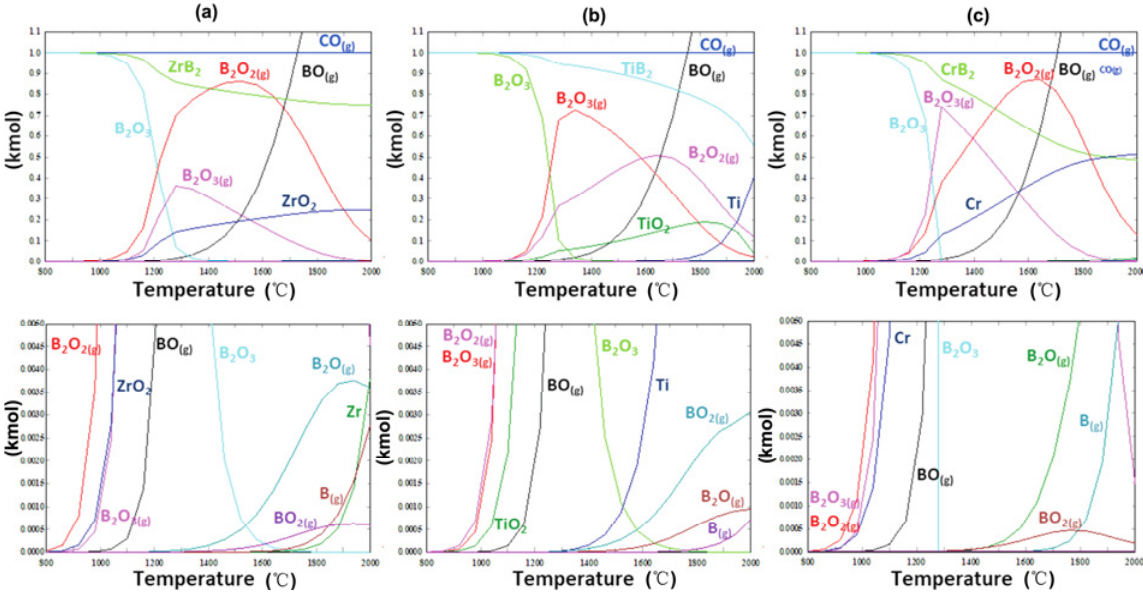
Fig. 12 Thermochemical equilibria of the products deriving from the reaction TMB 2 + 1CO (g) + 1B 2 O 3(g) , with TM = Zr (a), Ti (b), and Cr (c), as a function of the temperature and at constant pressure of 10 − 4 bar. In the bottom, a zoomed portion of the plots above highlights minor gaseous products and different amounts of released TM: relevant in the case of Cr, Ti, and negligible in the case of